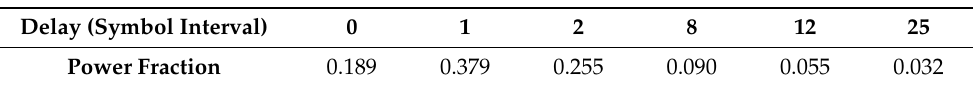
Table 2. Delay power profiles of ChA.